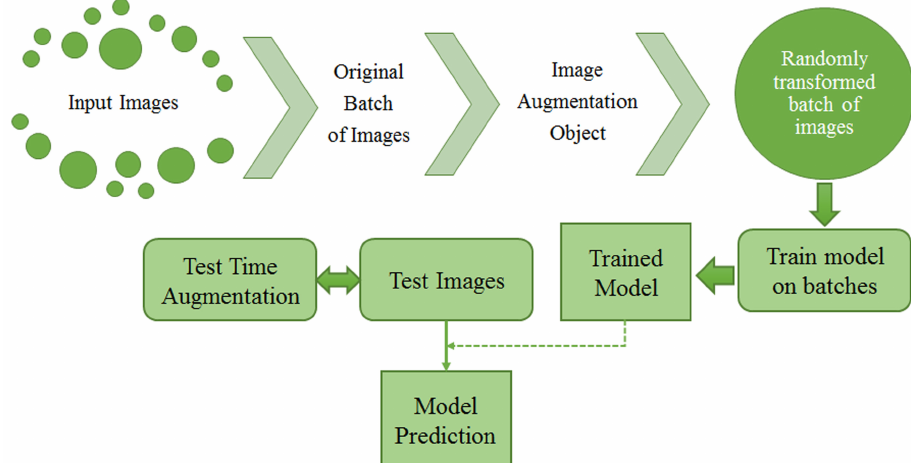
Figure 11. Train and test-time data augmentation.